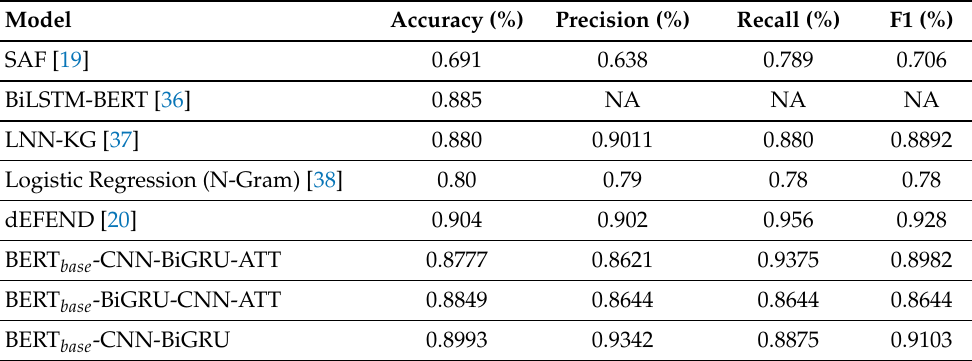
Figure 11. Performance comparisons (%) of all models in GossipCop. Table 4. Comparison (%) of the results obtained in the PolitiFact dataset w/o user posting behavior